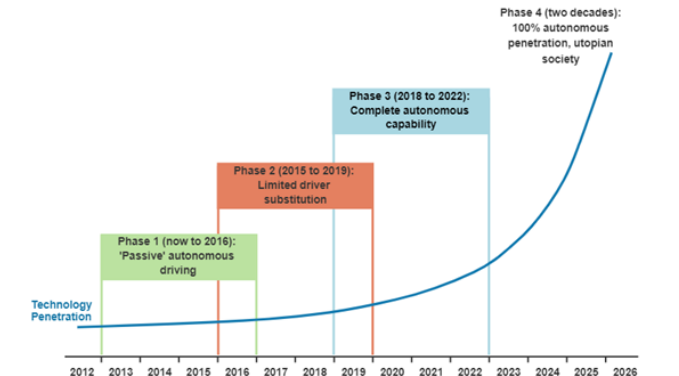
Figure 1. Adoption timeline for autonomous vehicles [13].